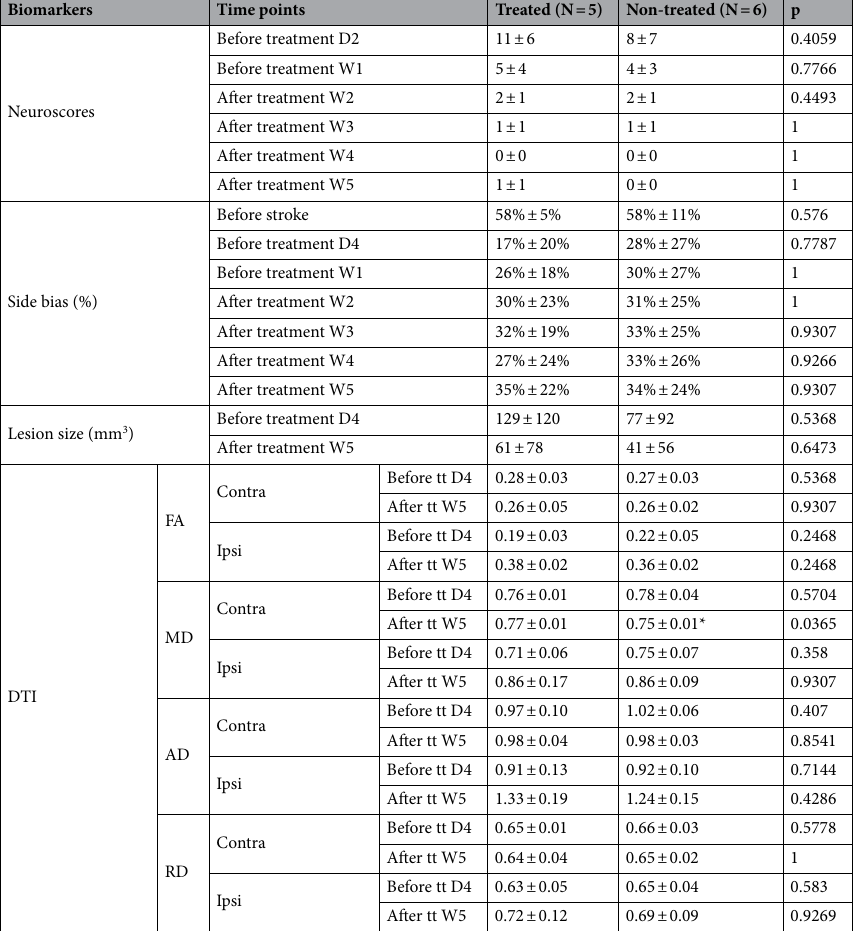
Table 1. Neurofunctional and neuroimaging readouts according to treatment group. Contra contralateral, D days, Ipsi ipsilateral, tt treatment, W Weeks, FA fractional anisotropy, MD mean diffusivity, AD axial diffusivity, RD radial diffusivity. p-values are given for Wilcoxon–Mann–Whitney test, *p <